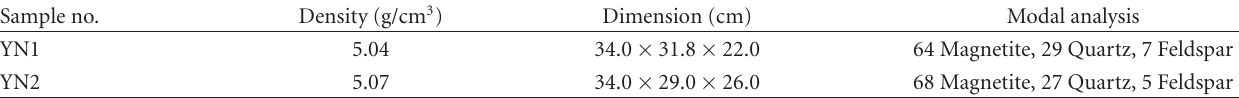
Figure 4: The residual resistivity images of sample YN1. (a) Line 1, (b) Line 2, and (c) Line 3. Table 1: Physical properties and geometric dimensions of specimens.